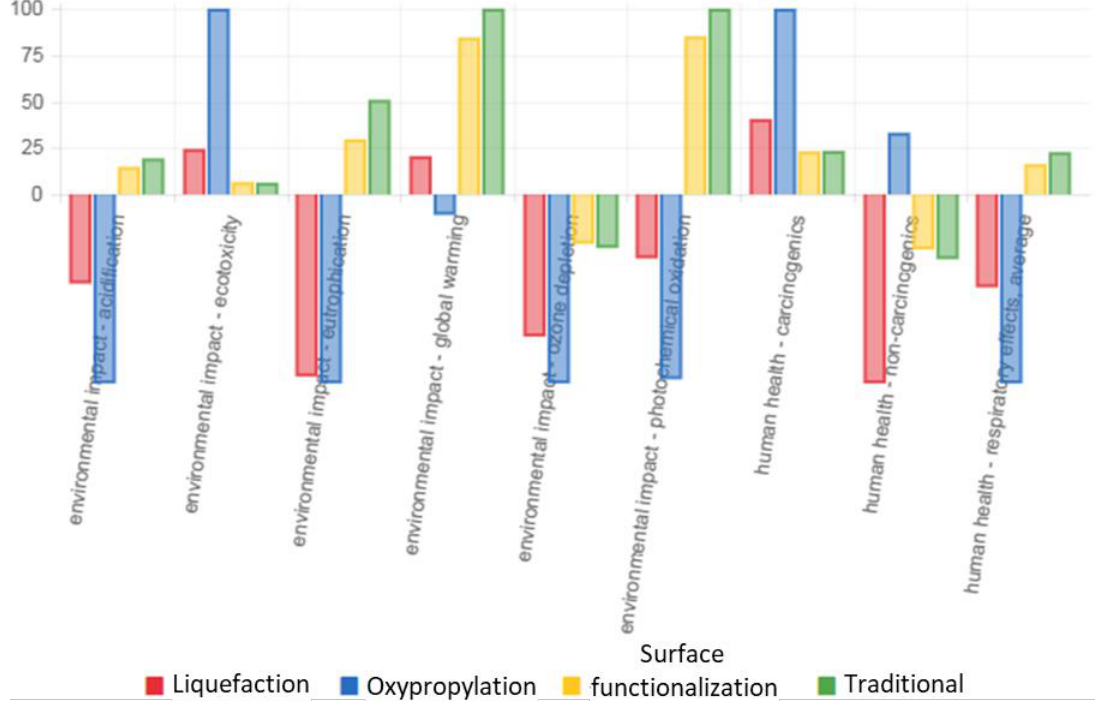
Figure 8. Life Cycle Assessment comparison of liquefaction, oxypropylation, surface functionalization, and traditional processing to manufacture polyurethane. For each indicator, the maximum result is set to 100% and the results of the other variants are displayed in relation to this